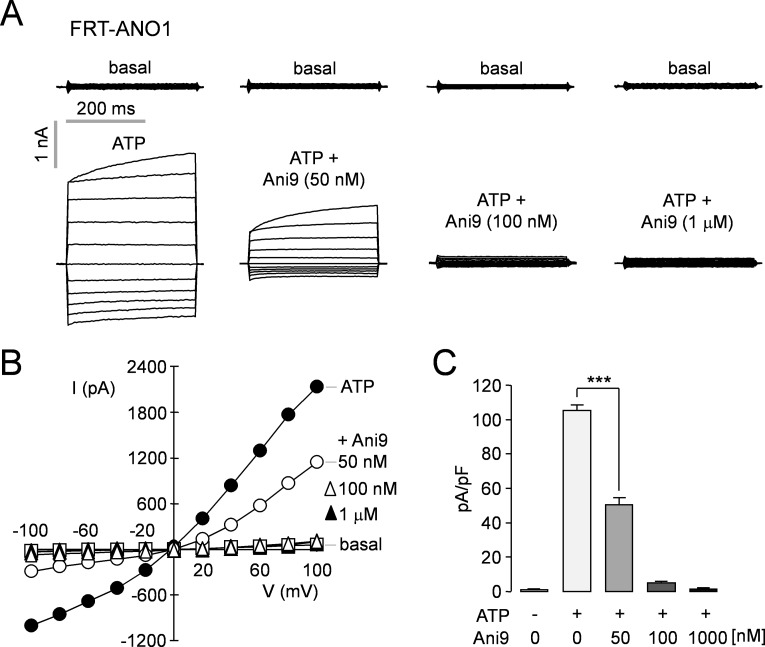
Patch-clamp analysis of ANO1 inhibition by Ani9 in FRT-ANO1 cells.A) Whole-cell ANO1 current was recorded at a holding potential at 0 mV and was pulsed to voltages between ± 100 mV (in steps of 20 mV) in the absence and presence of 50 nM, 100 nM and 1 μM Ani9. ANO1 was activated by 100 μM ATP. B) Current/voltage (I/V) plot of mean currents at the middle of each voltage pulse. C) The bar graphs summarize the current density data measured at + 80 mV (mean ± S.E., n = 4–6). ***P < 0.001.